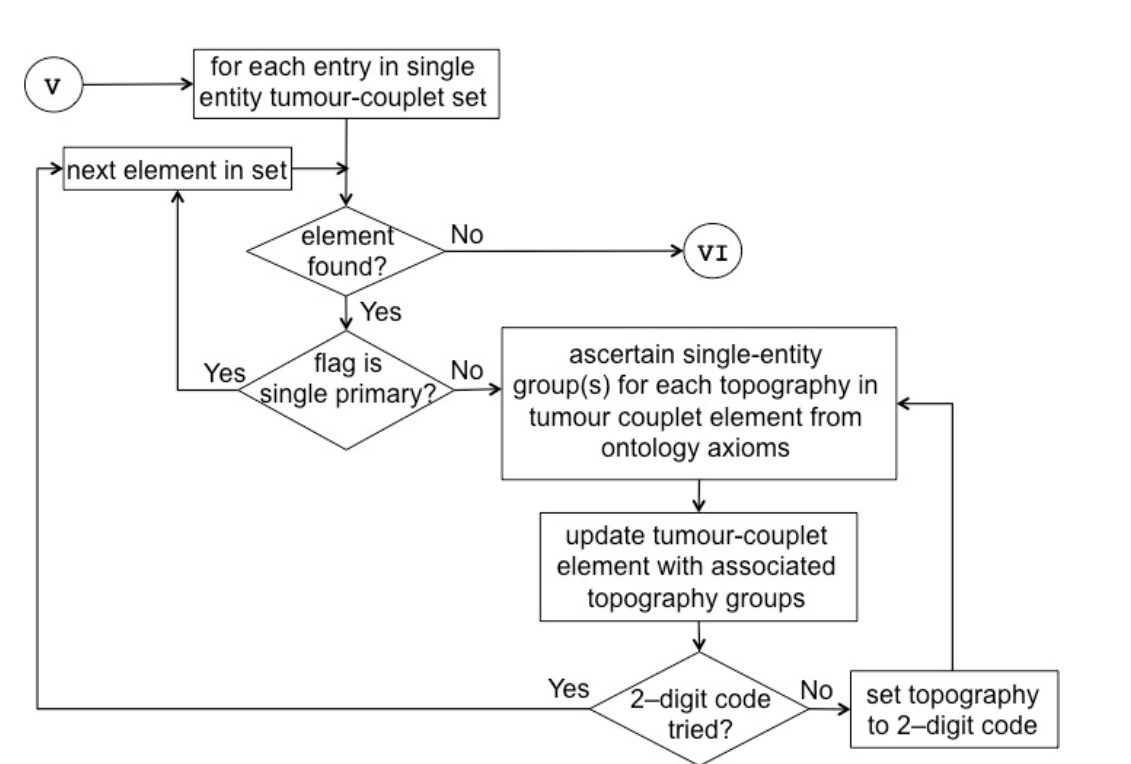
Figure A5. Process to determine single-entity topography groups for each pair of tumours previously added to a set.